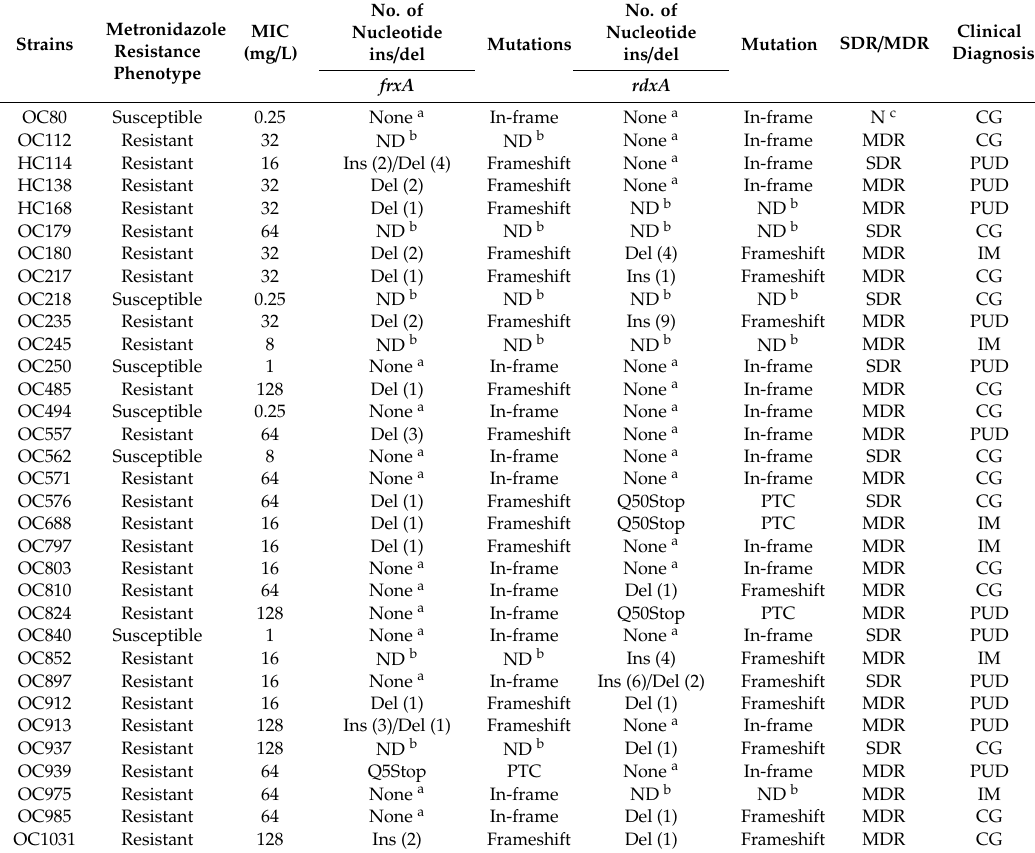
Table 5. Number of nucleotide insertion and deletion in frxA and rdxA genes involved in metronidazole resistance among H. pylori isolates used in this study.